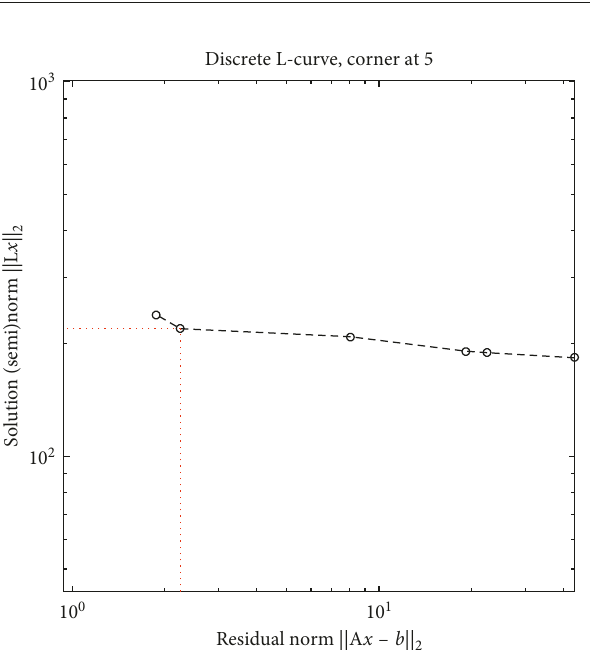
Figure 2: L-curve plot with the chosen corner in the dataset Cornell, by the adaptive pruning